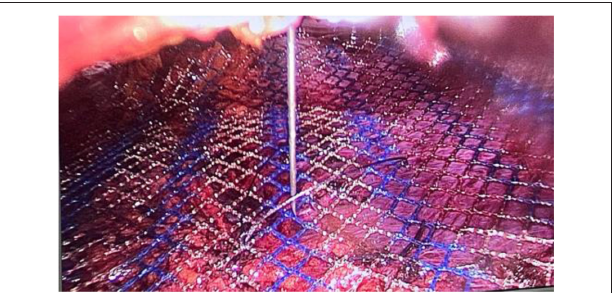
FIGURE 3 | Method 2 of patch